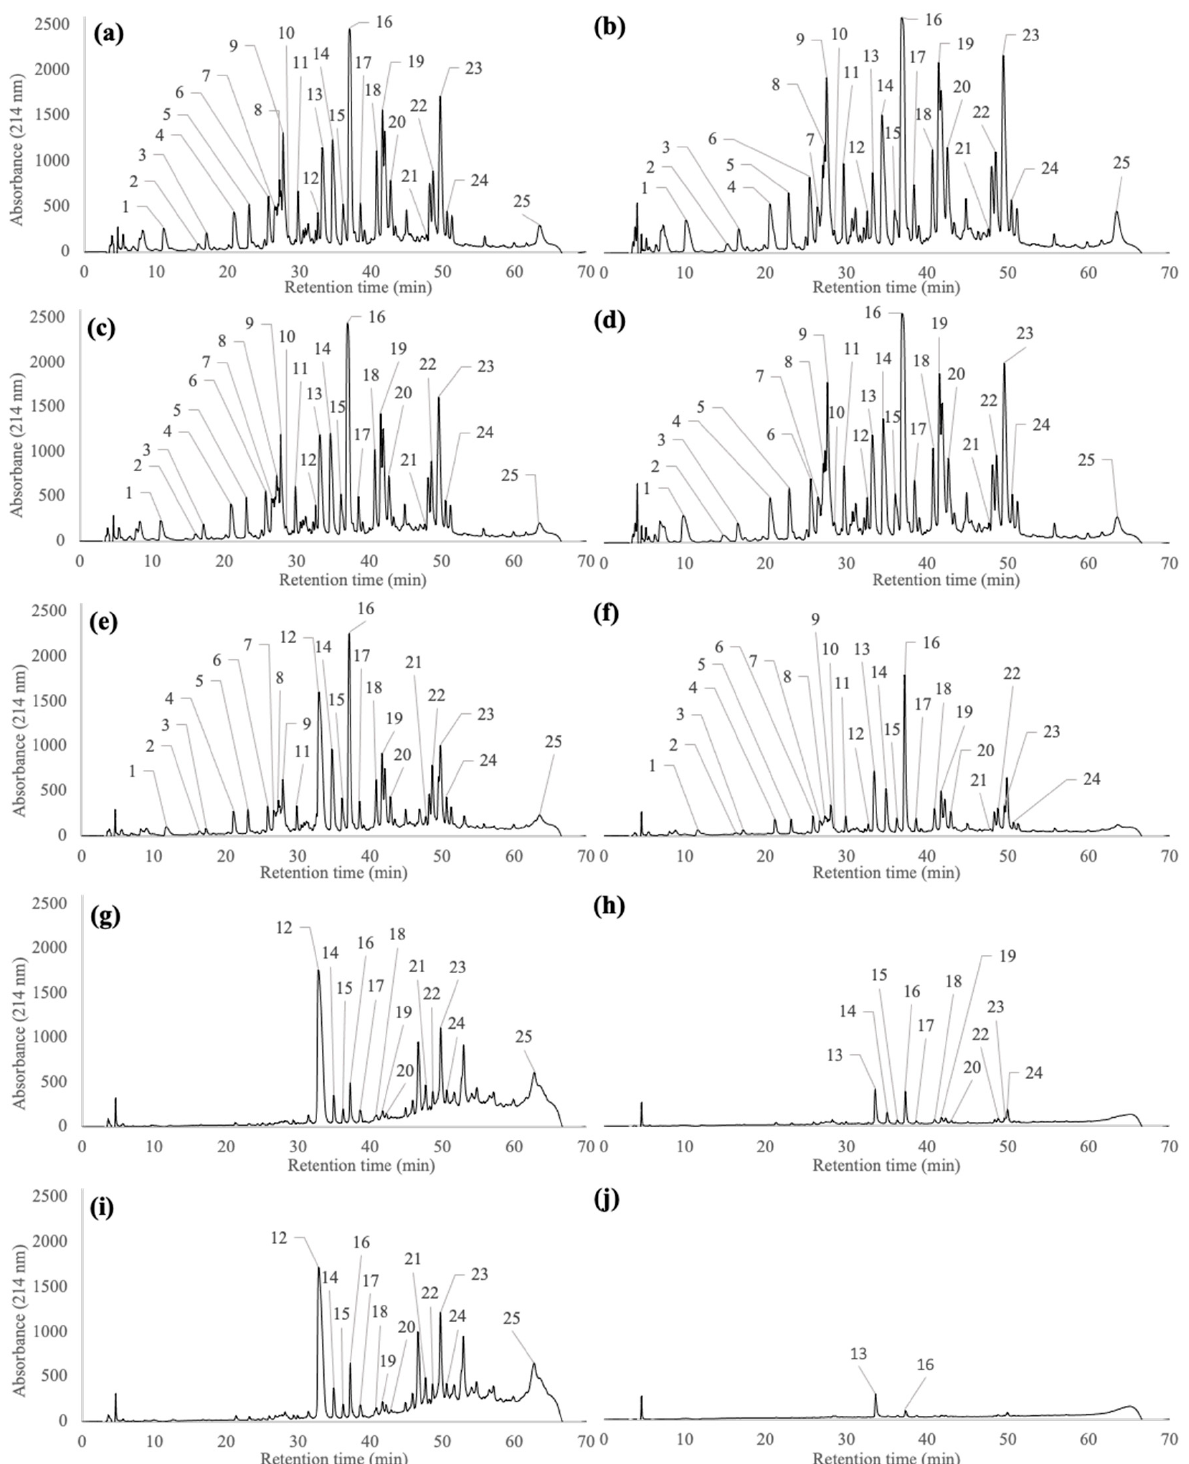
Figure 2. Peptide profiles of P1 ( a ), S1 ( b ), P2 ( c ), S2 ( d ), P3 ( e ), S3 ( f ), P4 ( g ), S4 ( h ), P5 ( i ), and S5 ( j ) obtained during the purification of Pf1-8 for each wash and centrifugation step. The identity of each peptide with its corresponding peak number is provided in Table 1.